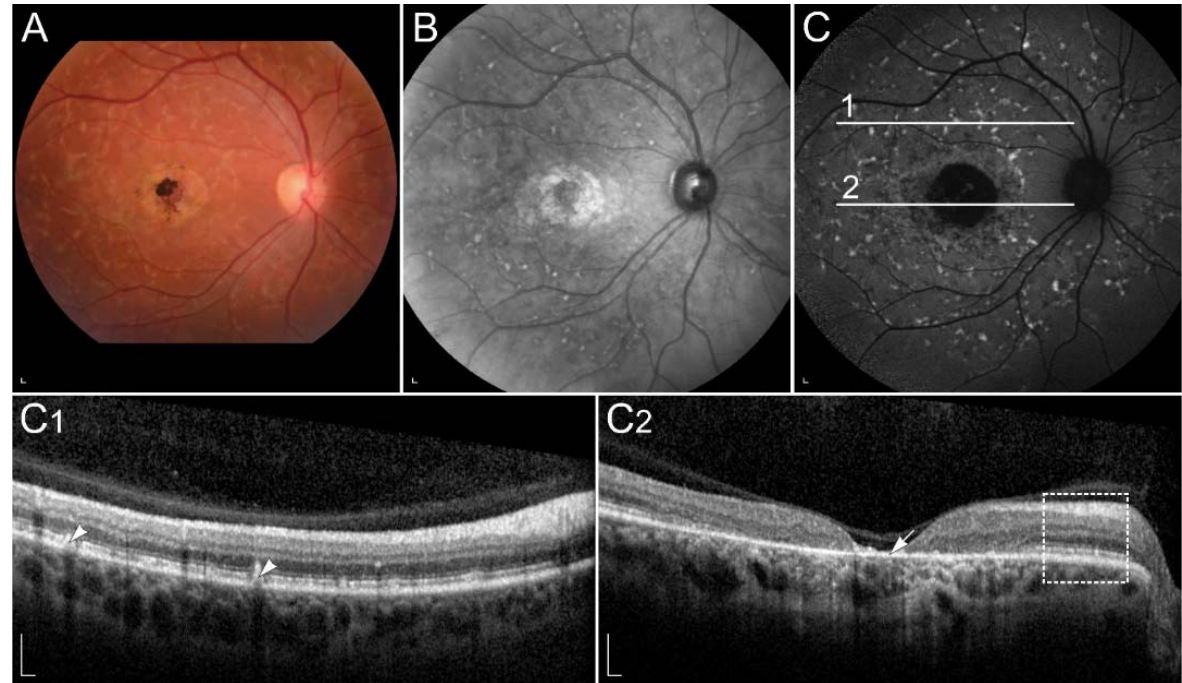
Figure 3. Clinical findings in a patient harbouring p.(Trp431*) and p.(Asp262Gly) in ABCA4 . Mac-ular affection, fundus flecks and peripapillary sparring (diagnostic triad) are shown on ( A ) colour fundus image, ( B ) fundus infrared image and ( C ) FAF image. On corresponding ( C1 , C2 ) SD-OCT images, (arrowheads) hyperautofluorescent flecks, (arrow) RPE atrophy and (rectangle) peripapillary sparing can also be observed. Patient’s best corrected Snellen decimal visual acuity was 0.1 on both eyes. Scale bars: 200 μ m. Source: Eye Hospital, University Medical Centre Ljubljana.